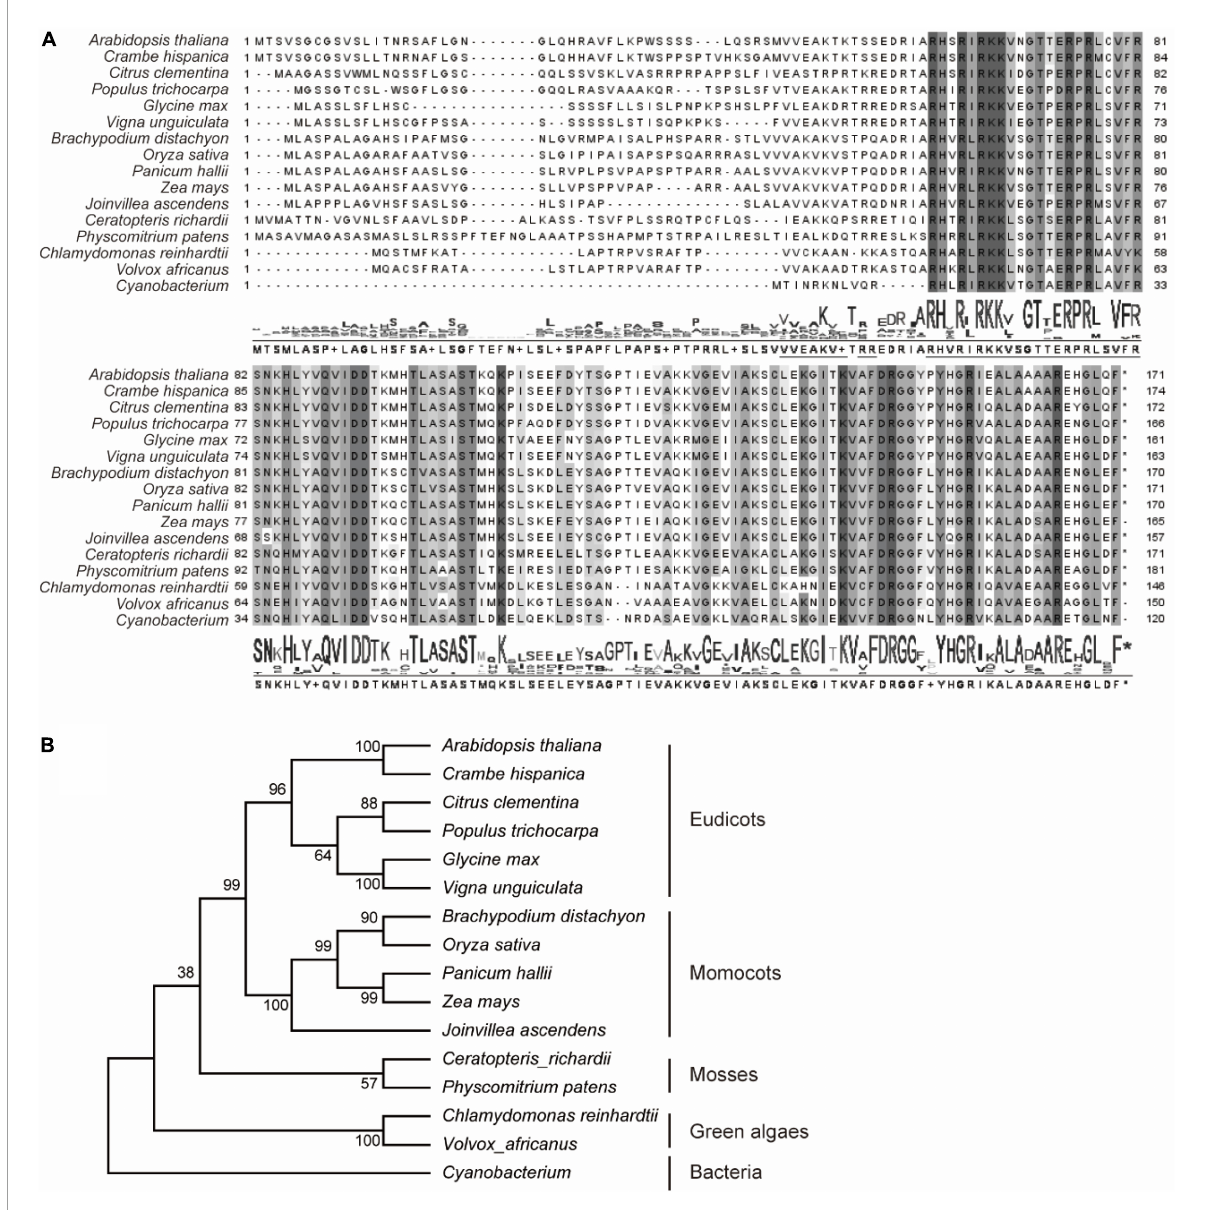
FIGURE1 Phylogenetic analysis of RPL18s. Sixteen represented PRPL18 homologs were obtained from plants and cyanobacterium using BlastP of AtPRPL18. Multiple sequence alignment was performed using Clustal Omega (A) , and phylogenetic tree was constructed by MEGA11 (B) . The conserved amino acid residues were highlighted by gray